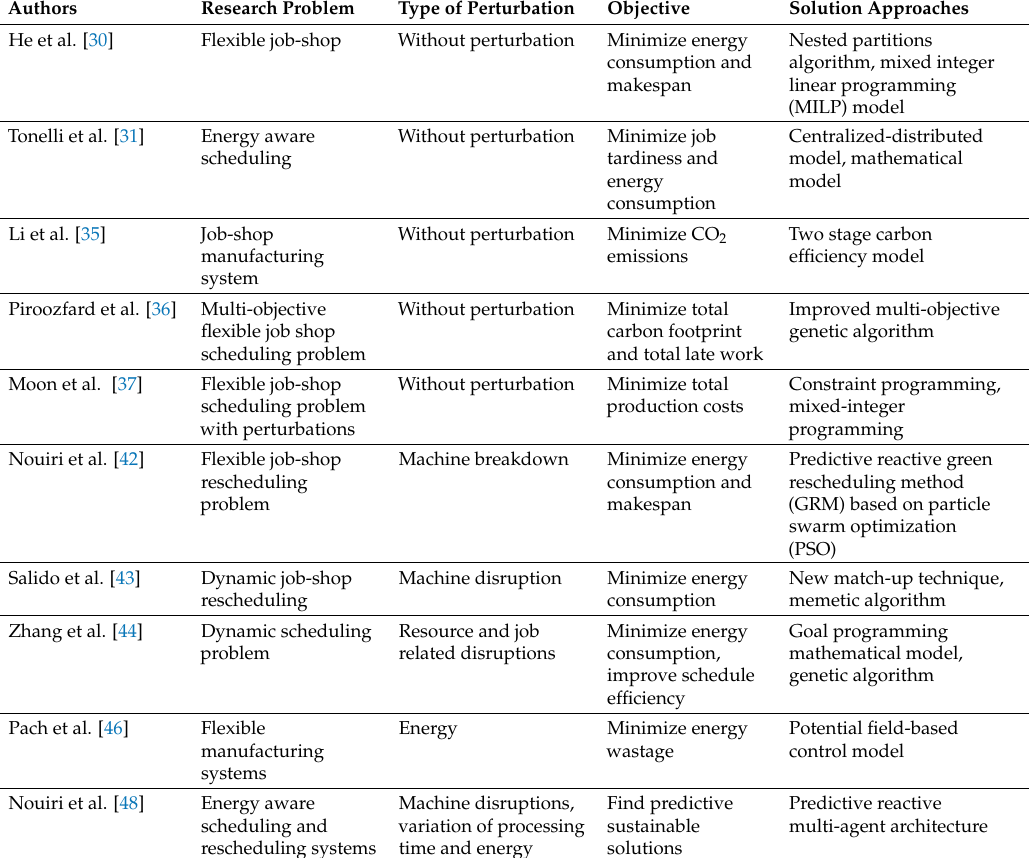
Table 1. Research most related to the problem